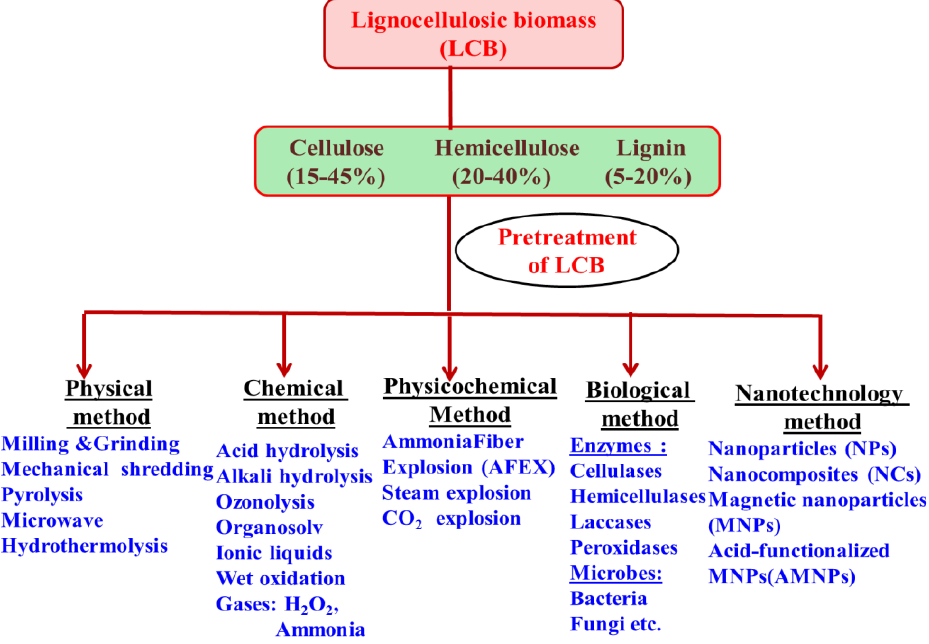
Figure 1. Different pretreatment methods for disintegrating lignocellulosic biomass materials.